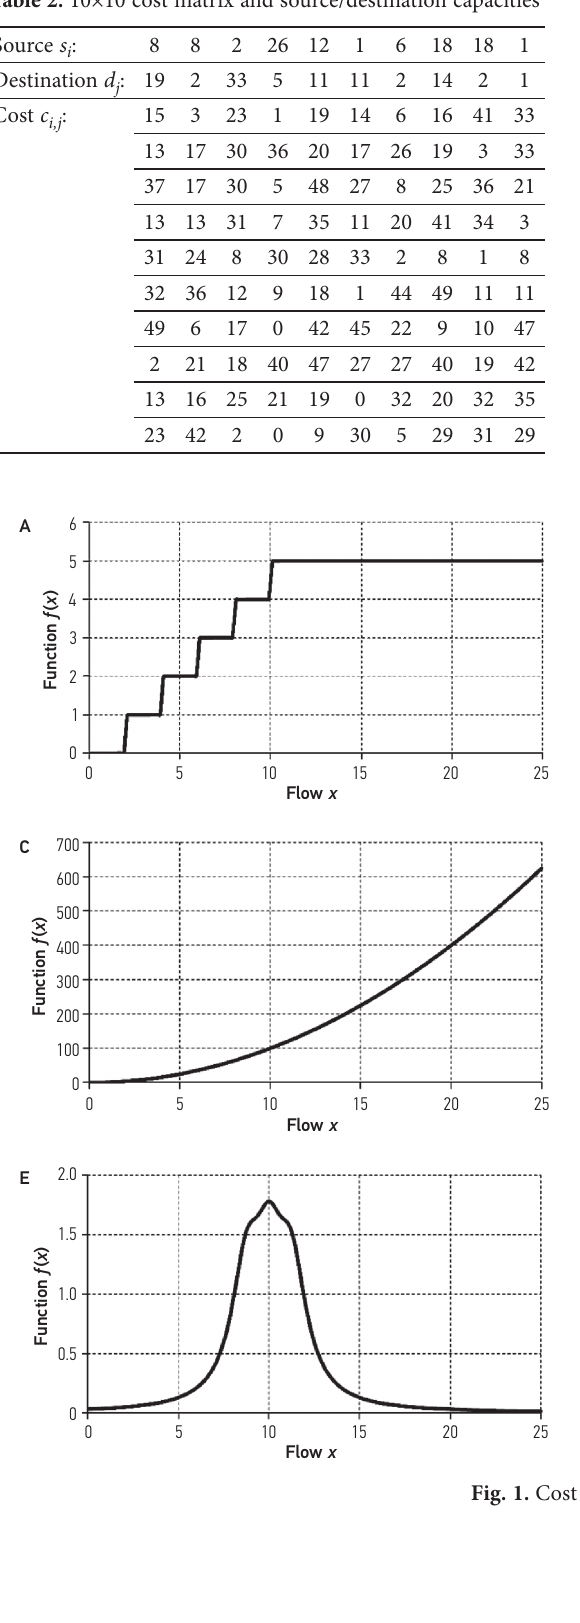
Table 2. 10×10 cost matrix and source/destination